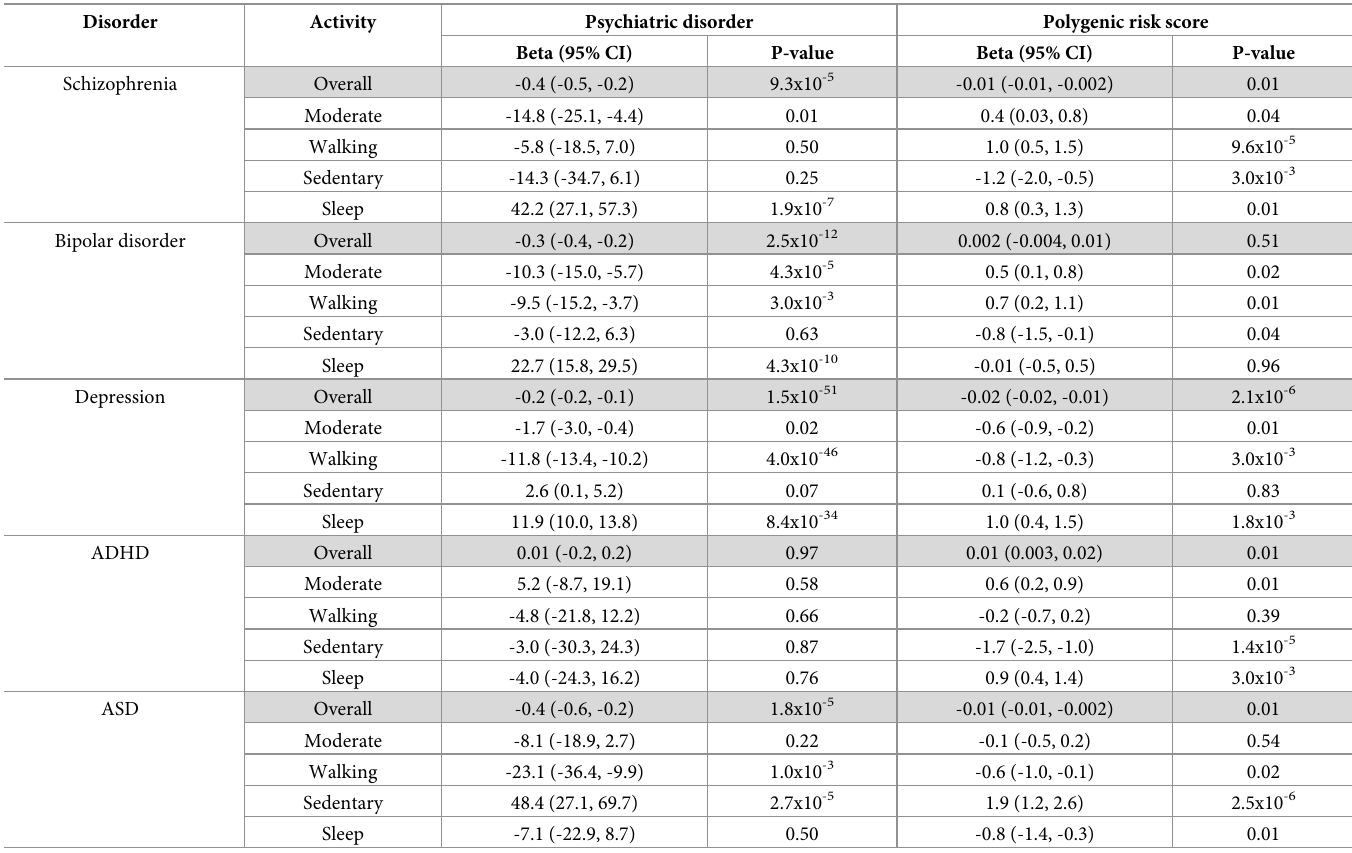
Columns represent the disorder, type of activity, effect size (beta), 95% confidence intervals, and FDR-corrected p-value of the association between either a diagnosis